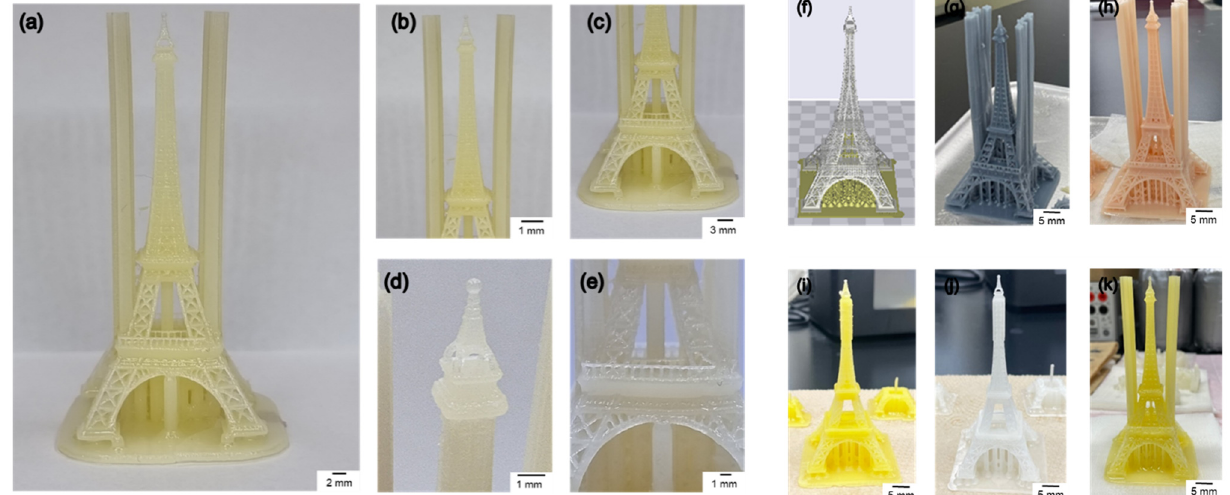
Figure 10. Eiffel Tower model printed by a 3D printer with different resin colors. ( a ) Eiffel Tower printed using yellow color resin; ( b ) Eiffel Tower top part; ( c ) Eiffel Tower bottom part; ( d ) Eiffel Tower top vertex; ( e ) Eiffel Tower middle part; ( f ) Eiffel Tower 3D CAD model; Eiffel Tower model printed using ( g ) gray color resin, ( h ) pink color resin, ( i ) fluorescent resin, ( j ) white color resin, and ( k ) yellow color resin.